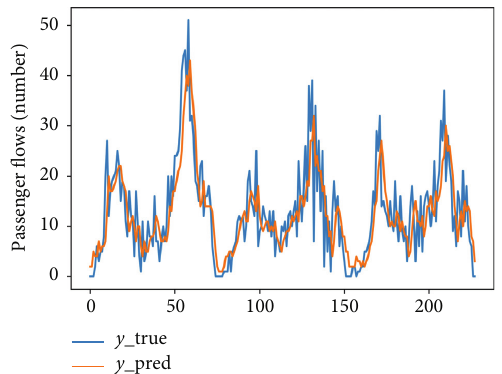
Figure 14: Regression integration prediction results when the time step is 15